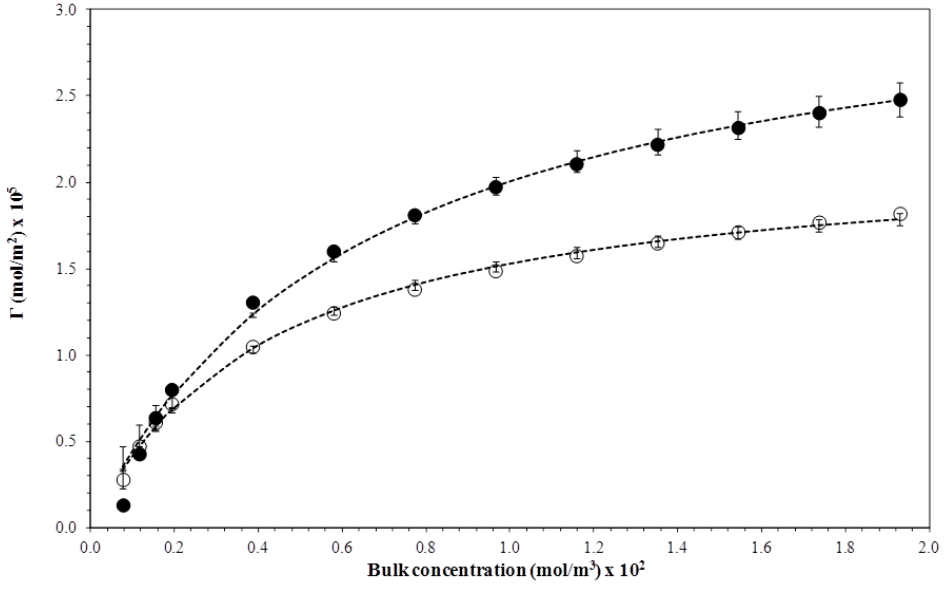
Figure 8. Gibbs adsorption isotherms for the biosurfactant obtained at temperatures of ( ● ) 15 °C and ( ○ ) 35 °C. Curves fitted by the Langmuir adsorption model.